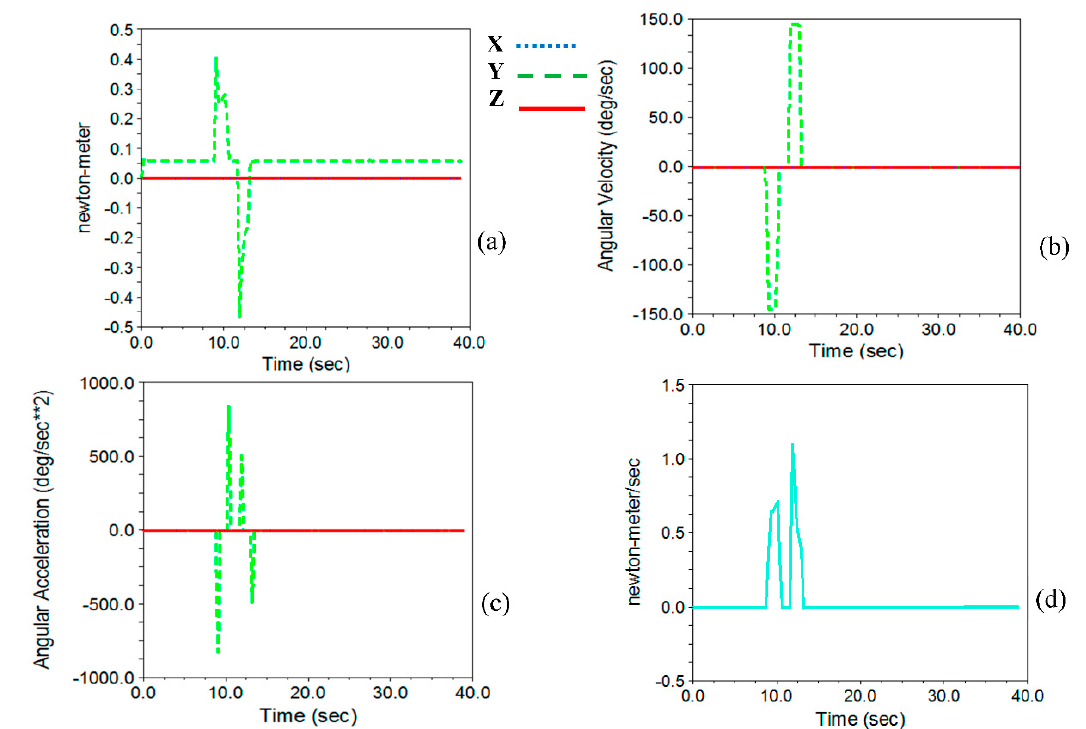
Figure 25. Results of ADAMS software simulation to determine the motor characteristics of the gutting subset (10 fish per minute). In this figure, ( a – d ) are torque, angular velocity, angular acceleration, and required power respectively.